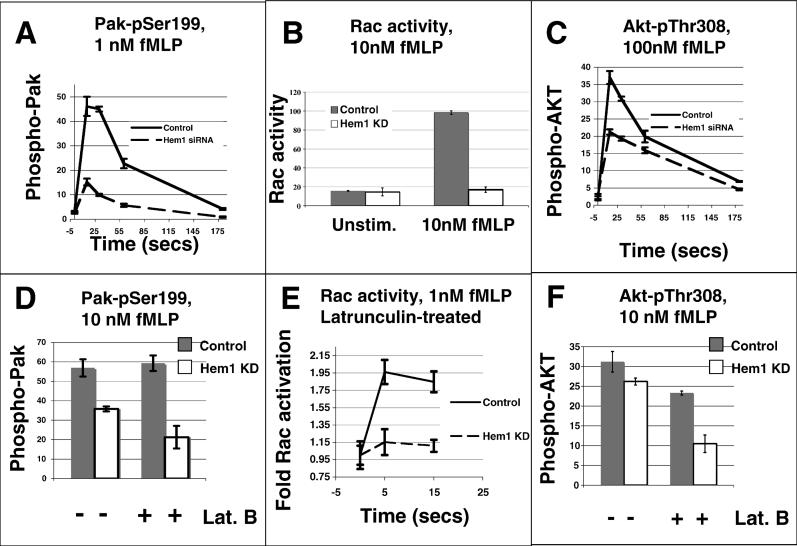
Rac Activation and PIP3 Generation Are Dependent on Hem-1Control or Hem-1 knockdown cells were stimulated in suspension with the indicated dose of agonist. TCA was used to stop the reaction (A, C, D, F) and precipitate proteins for immunoblotting or cells were lysed with NP-40, and Rac-GTP was captured with the Rac-binding domain of PAK (B, E). Western blots were quantitated using fluorescent secondary antibodies and the Odyssey system. The y-axis indicates integrated (background-subtracted) fluorescence of secondary antibody on blots in arbitrary units. All experiments were performed in triplicate and are shown with standard error of mean.(A) Effect of Hem-1 depletion on phosphorylation of PAK (readout of Rac activation) for cells treated with 1 nM fMLP.(B) Effect of Hem-1 depletion on Rac activation (assayed with PAK GBD pulldown) for cells treated with 10 nM fMLP for 15 s.(C) Effect of Hem-1 depletion on phosphorylation of Akt/PKB (readout of PIP3 production) for cells stimulated with 100 nM fMLP.(D–F) Defects in PIP3 generation and Rac activation are independent of actin polymerization. Results are shown with standard error for cells stimulated in triplicate at 37 °C. (D) Cells were preincubated with 10 μM latrunculin B, stimulated with 10 nM fMLP for 30 s, and blotted with antibodies to PAK-phospho-Ser199. (E) Cells were preincubated with 10 μM latrunculin, stimulated with 1 nM fMLP for 15 s, lysed, and incubated with PAK-GBD (to capture Rac-GTP), and blotted for Rac. (F) Cells were preincubated with 10 μM latrunculin B, stimulated with 10 nM fMLP for 15 s, and then blotted with antibodies to Akt/PKB phospho-Thr308.